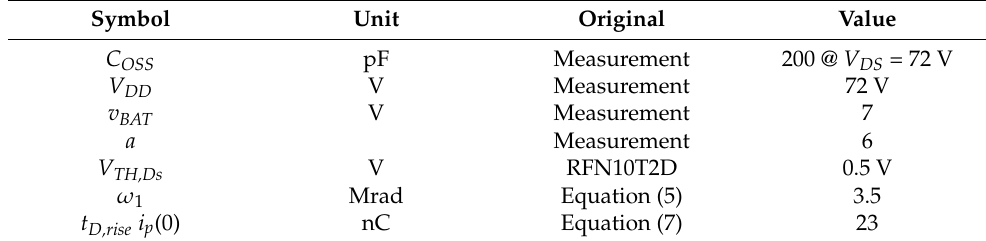
Table 1. Parameters used to estimate the diode turn-on